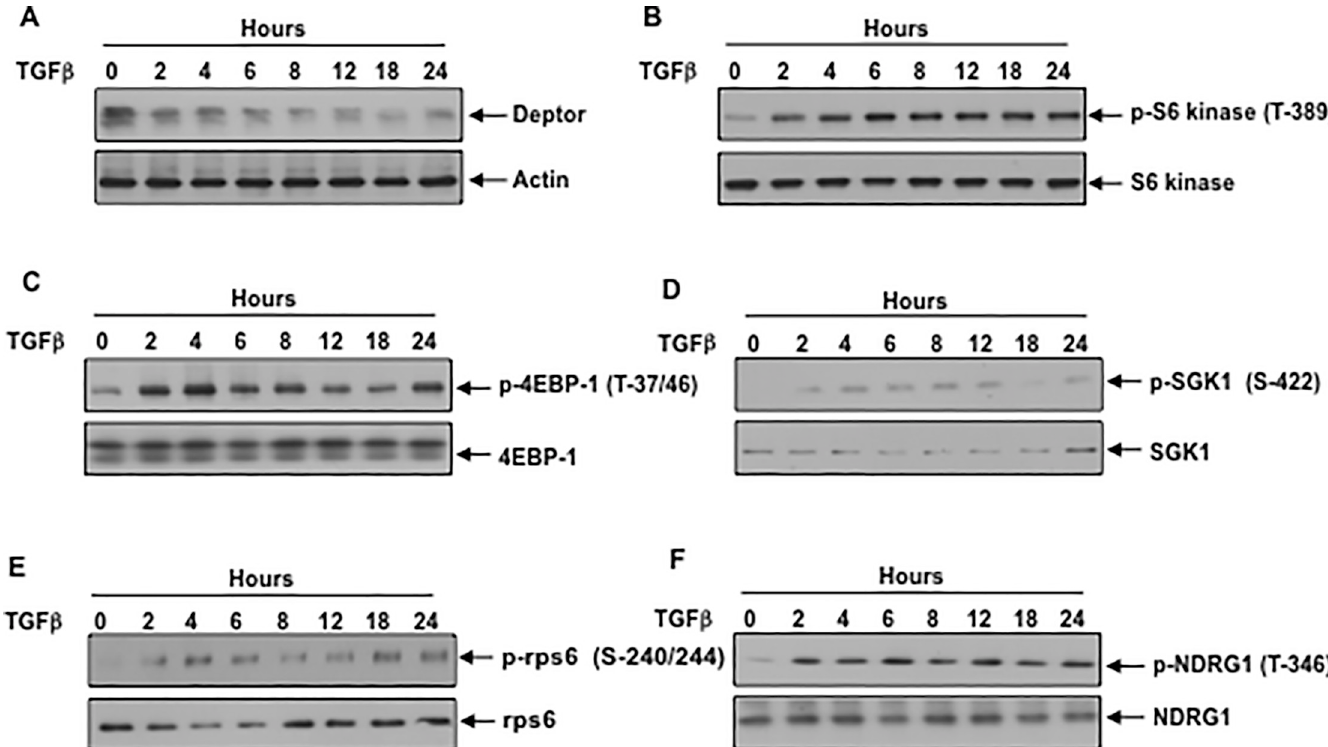
Fig 1. TGF β downregulates deptor in association with sustained activation of mTORC1 and mTORC2. Serum-starved podocytes were incubated with 2 ng/ml TGF β for the indicated periods of time. Cleared cell lysates were immunoblotted with deptor, actin (panel A); phospho-S6 kinase (Thr-389), S6 kinase (panel B); phospho-4EBP-1 (Thr-37/46), 4EBP-1 (panel C); phospho-SGK1 (Ser-422), SGK1 (panel D); phospho-rps6 (Ser-240/244), rps6 (panel E); phospho-NDRG1 (Ser-346), NDRG1(panel F). Representative blots from three independent experiments are shown in each panel. The quantification is shown in the S2 Fig.